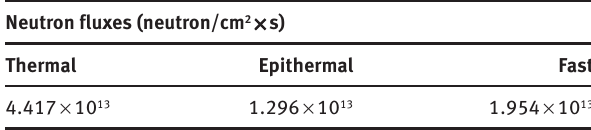
Table 1: Neutron fluxes in sample position at reactor power of 4 MW.